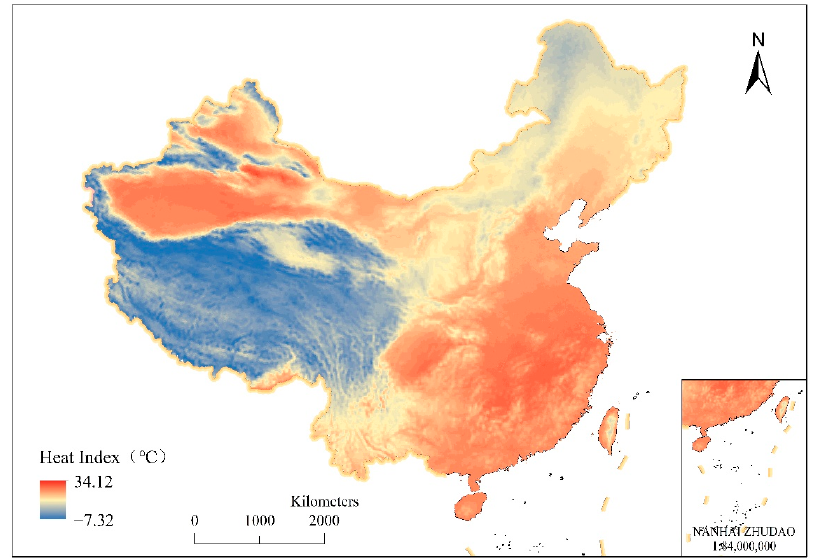
Figure 5. The mean HIs in China during August 2020.